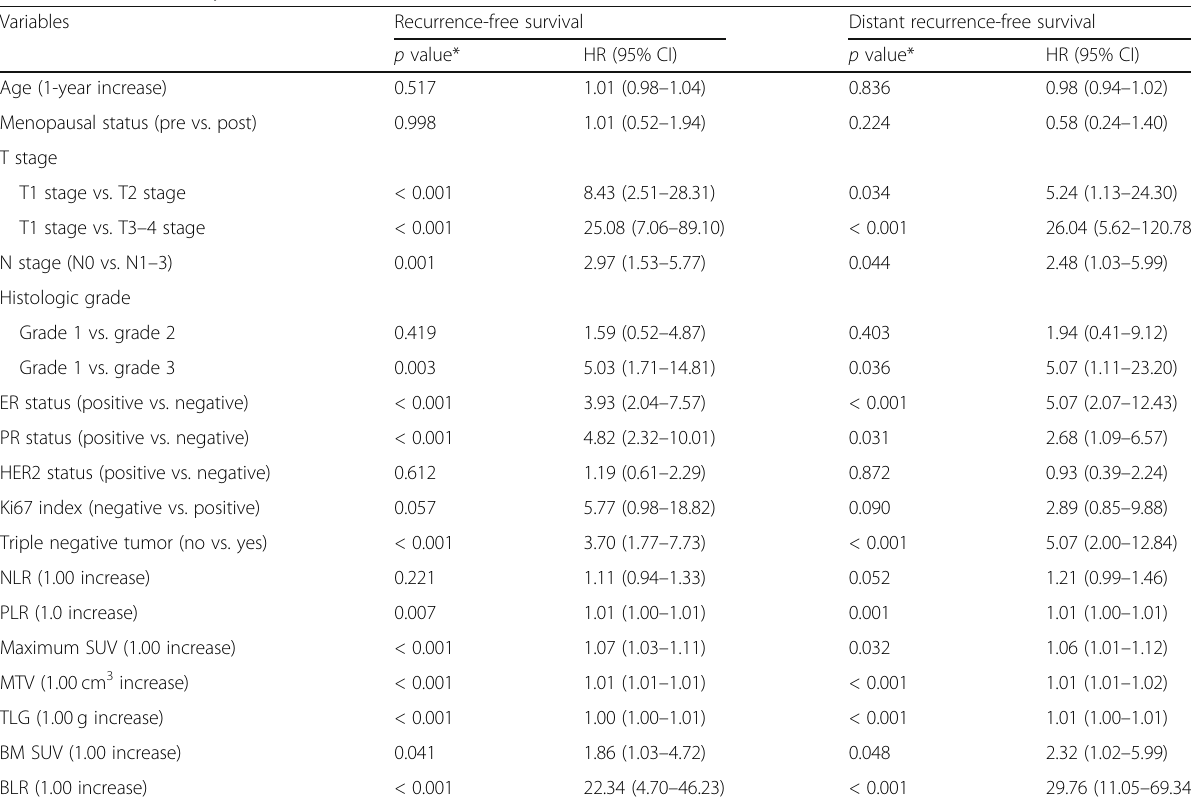
Table 3 Univariate analysis for recurrence-free survival and distant recurrence-free